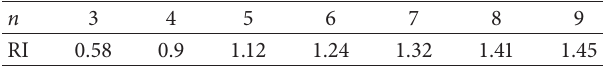
Table 2: Random index of a matrix.